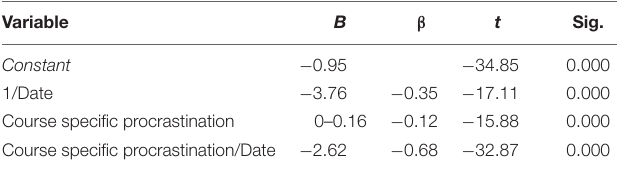
TABLE 3 | Regression analysis summary of date and course specific procrastination predicting daily assignments completed.